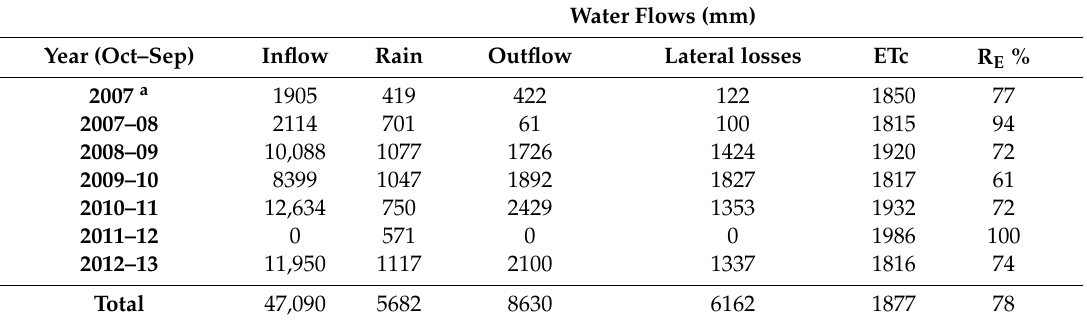
SFCW water flows. Inflows, outflows, estimated lateral losses, estimated crop evapotranspiration (E C ), and removal e ffi ciency (R E ) are